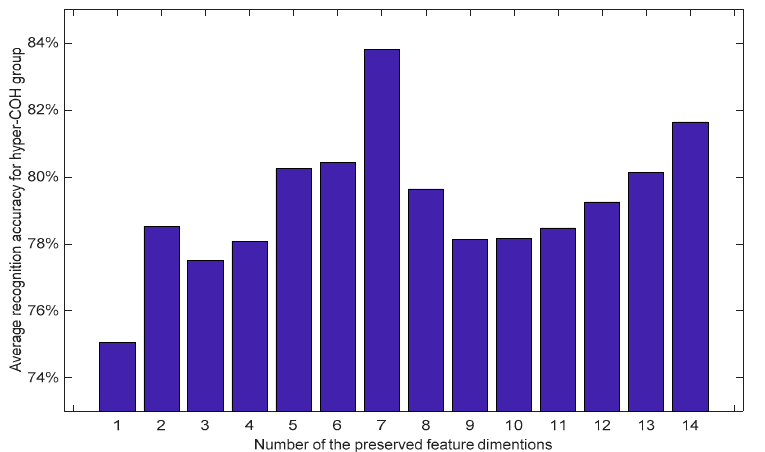
Figure 8. PCA analysis on the feature dimensions for the proposed classification features from hyper-COH group. The recognitions are the mean performance through SVM using the LOO approach.